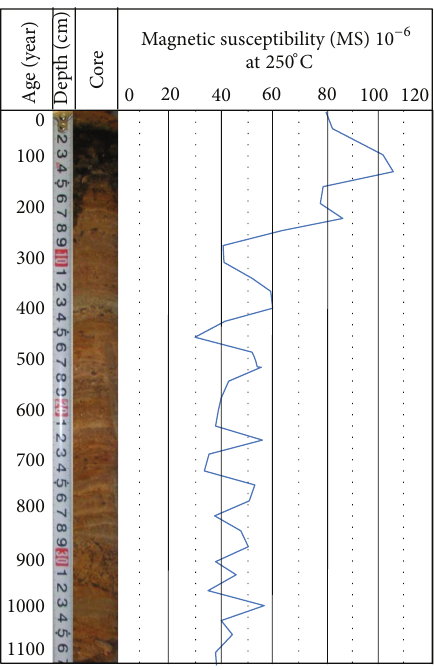
Figure4:Magneticvaluesafterheatingto250 ∘ Calongthecorefrom sebkha Mhabeul.